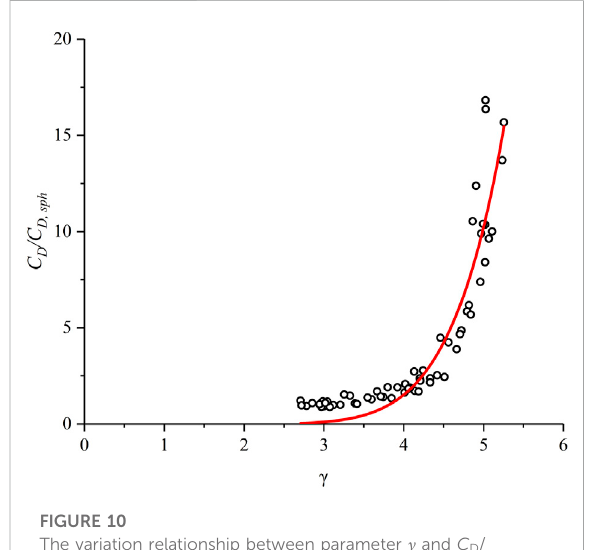
FIGURE 10 The variation relationship between parameter γ and C D / C D, sph .